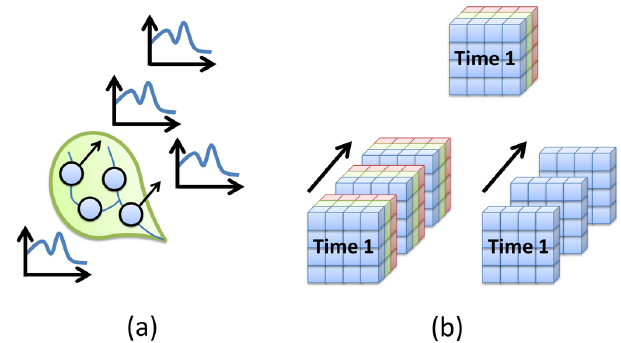
Fig. 4. Traditional data storage for (a) time series and (b) grids.